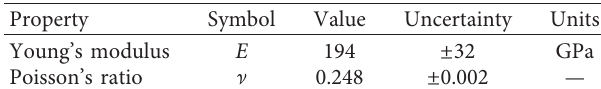
Table 3: Young’s modulus and Poisson’s ratio results determined by the IET optimisation procedure.